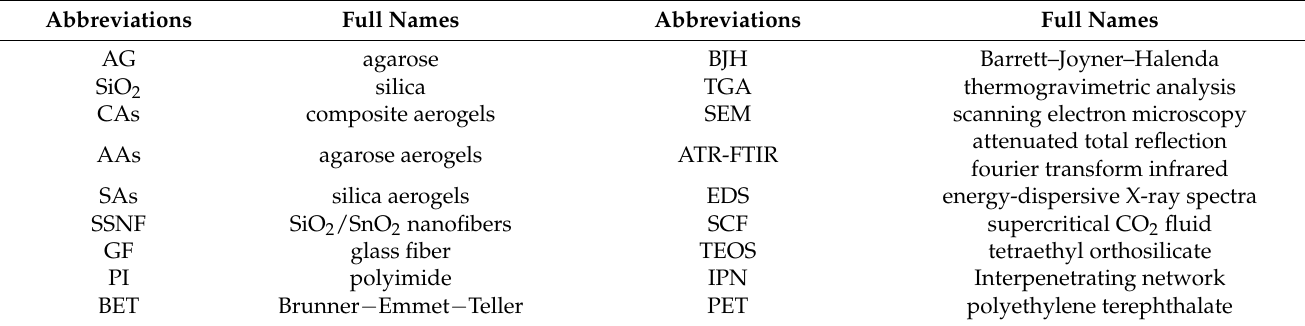
Table 3. Abbreviations and full names of the work.